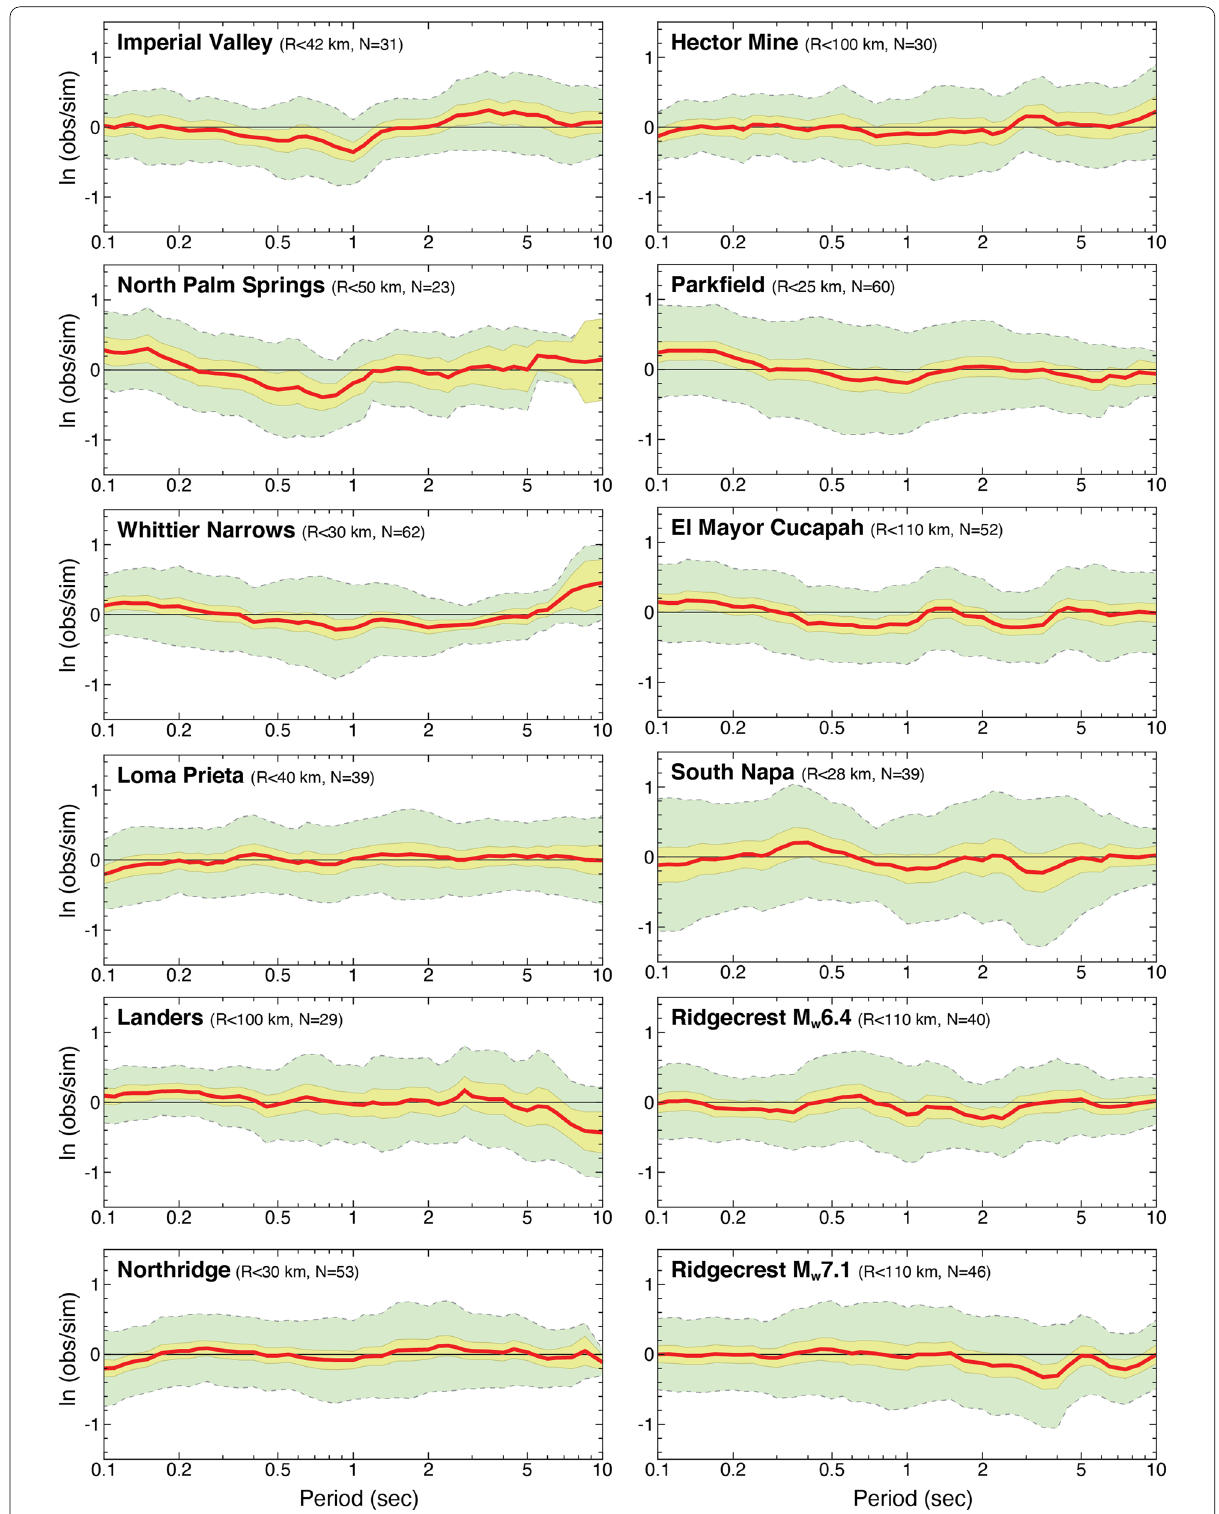
Fig. 10 RotD50 GoF results in the period range 0.1 to 10 s for the lowest misfit simulation for each of the 12 validation events. The maximum distance and number of sites for each event are listed in the upper right of each panel. The red line is the bias (Eq. 4), the green region is the standard deviation (Eq. 5) and the yellow region is the 95% confidence interval of the